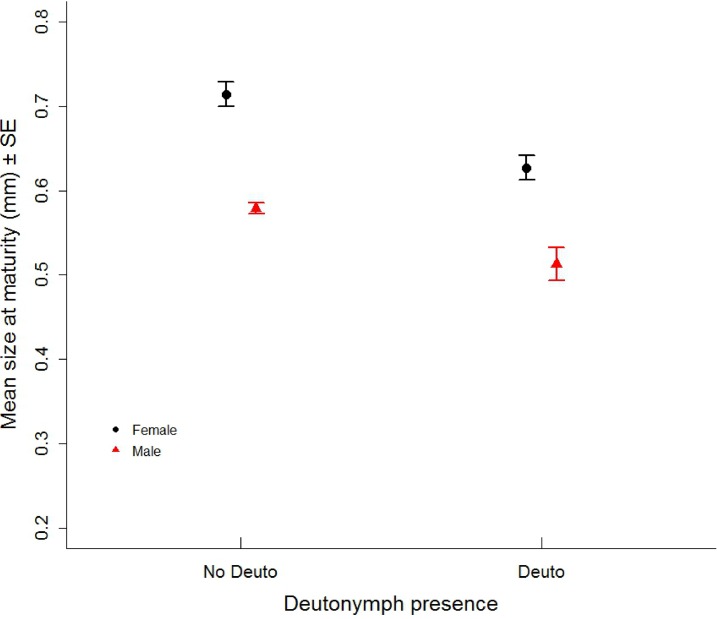
Size at maturity.Size at maturity (mean ± s.e.) for dispersers (Deuto) and non-dispersers (No Deuto), in females (black points and lines) and fighter males (red triangles and lines).